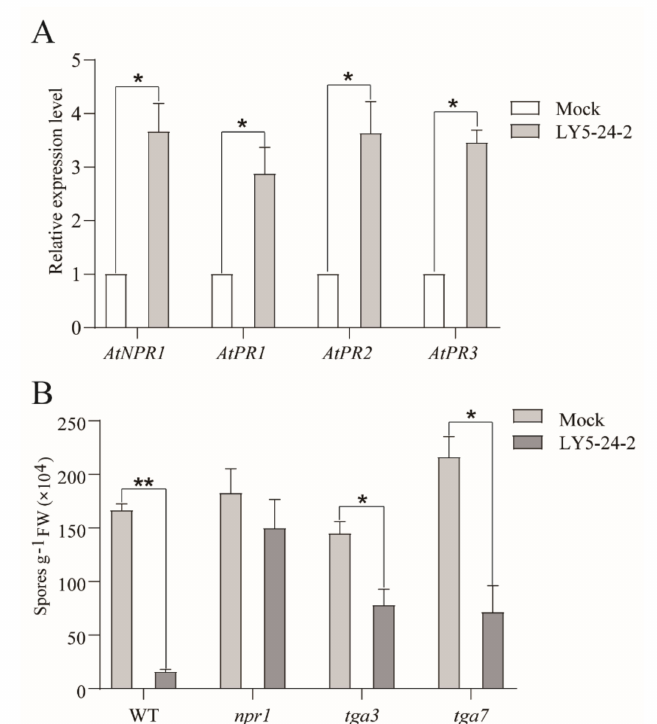
Figure 7. Dependence of LY5-24-2 on SA signaling for immune-inducing functions. ( A ) AtNPR1 , AtPR1 , AtPR2 and AtPR3 expression analysis in A. thaliana leaves at 24 h after a treatment with 100 µ M of LY5-24-2. AtTUB4 was served as an internal control. ( B ) Sporulation level of H. arabidopsidis Noco2 on of WT, npr1 , tga3 and tga7 spraying-inoculated with H. arabidopsidis Noco2 at 24 h after a treatment with 100 µ M of LY5-24-2. Data are shown as the mean of three biological replicates ± SD. The * represent significant difference (* p < 0.05, ** p <